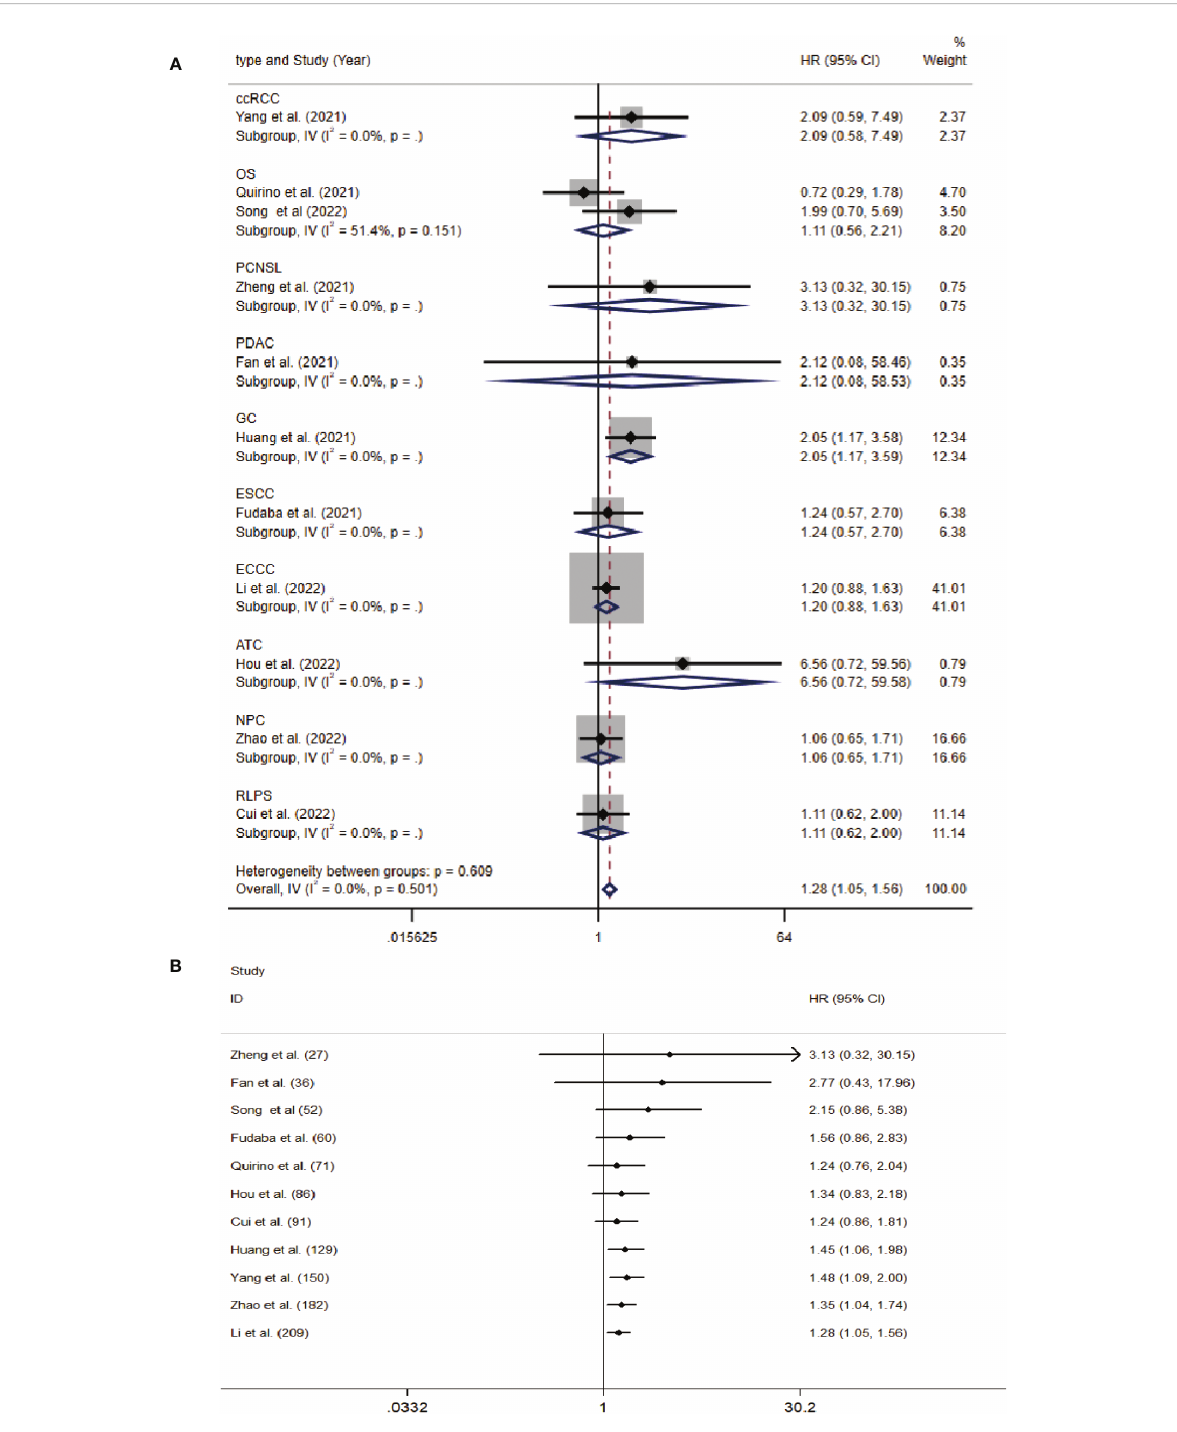
FIGURE 4 (A) Forest plots of studies evaluating hazard ratios (HRs) of Siglec-15 for overall survival in different subgroups of tumor type. (B) Cumulative meta-analysis by patients ’